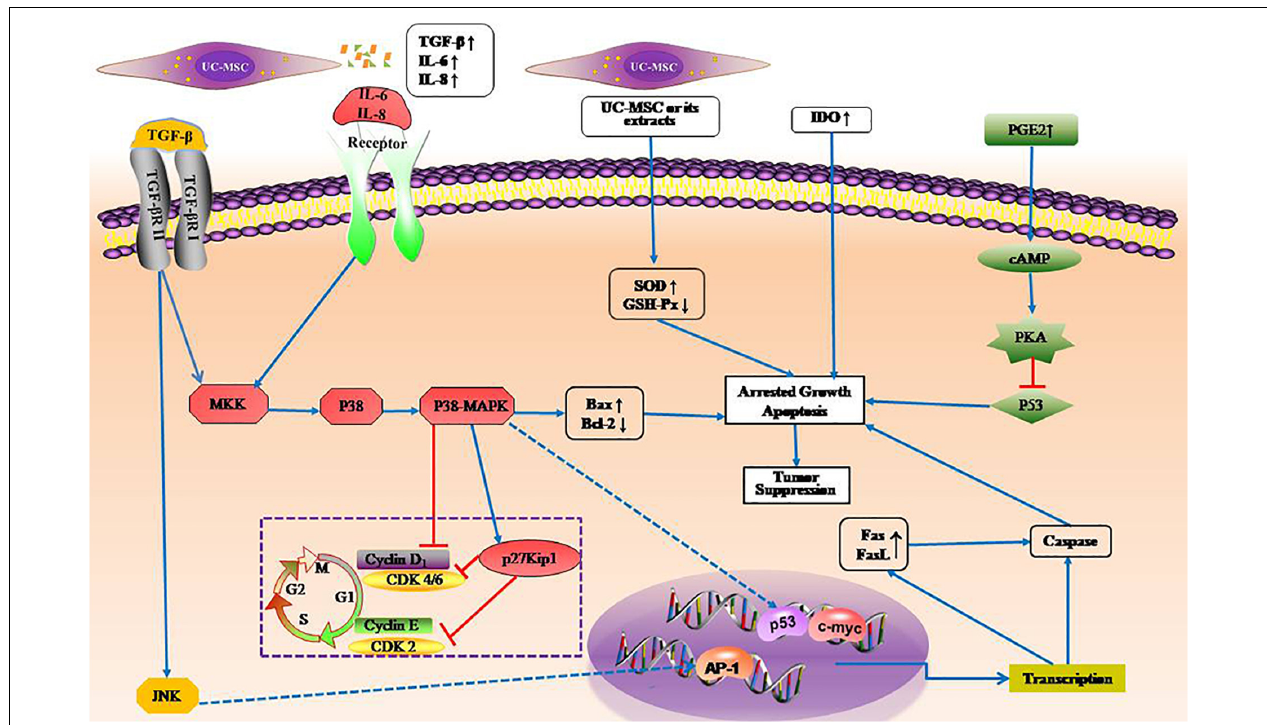
FIGURE 1 | Possible signal pathways of umbilical cord mesenchymal stem cells to hematological tumors. TGF β , IL6, and IL8 not only arrest cell cycle in Go or G1 phase inhibiting the proliferation of leukemia cells, but also promote apoptosis of leukemia cells. UC-MSCs or their secretions induce lymphoma cell apoptosis by oxidative stress pathway by enhancing SOD activity and decreasing GSH-Px activity. Forced expression of IDO enhance proliferation inhibitory effect on leukemia cells. PGE2 promoting leukemogenesis by inhibiting activity of p53 via cAMP-PKA pathway. SOD, superoxide dismutase; GSH-Px, glutathione peroxidase; IDO, indoleamine